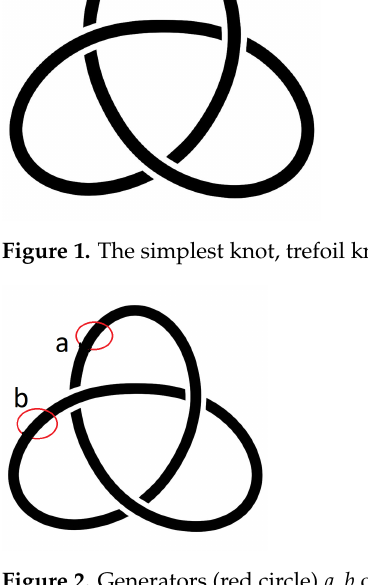
Figure 2. Generators (red circle) a , b of knot group for trefoil 3 1